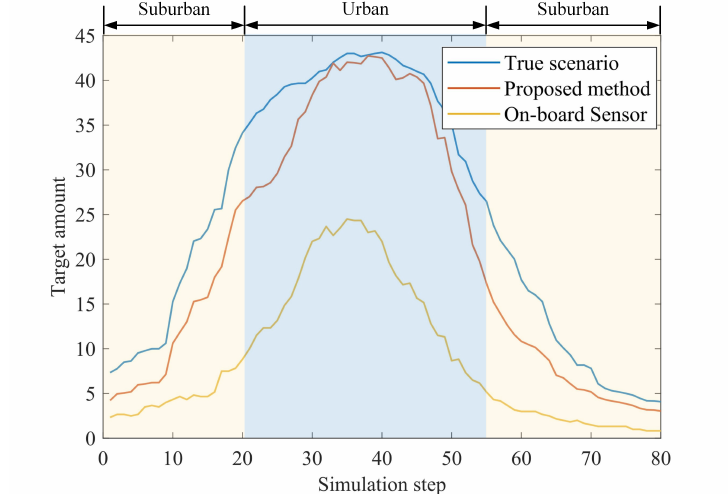
Figure 9. Perception integrity in terms of the number of targets